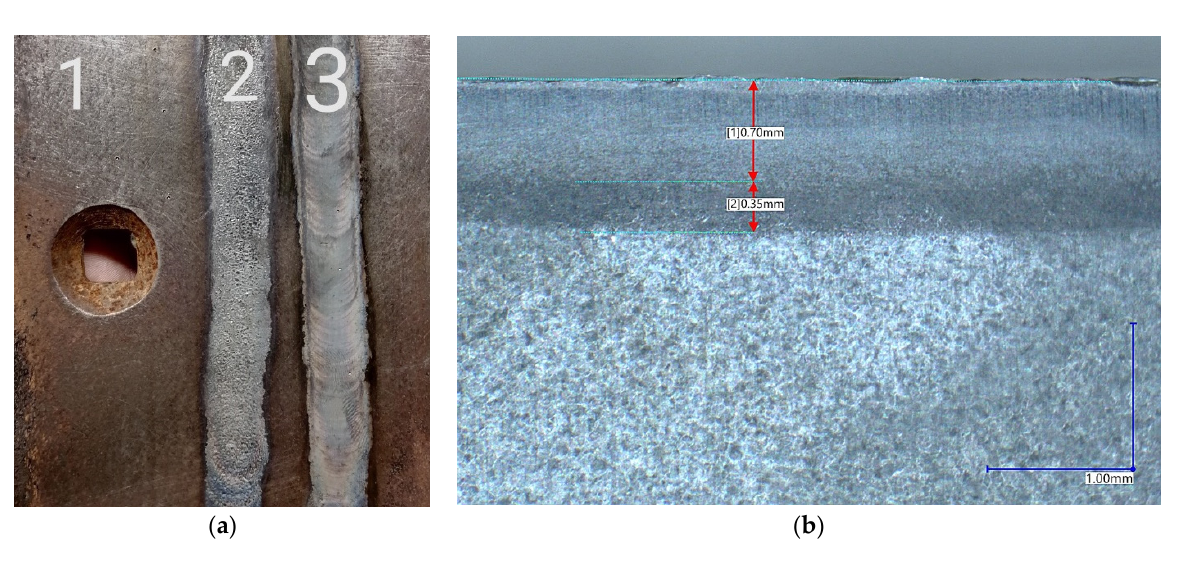
Figure 2. The effect of surface pretreatment: ( a ) the view, ( b ) the cross-section of hardening line 2; 1—non-hardened surface; 2—surface hardened without additional treatments; 3—surface preliminarily cleaned from surface marks (rust, scratches, etc.) using a grinding machine before hardening.